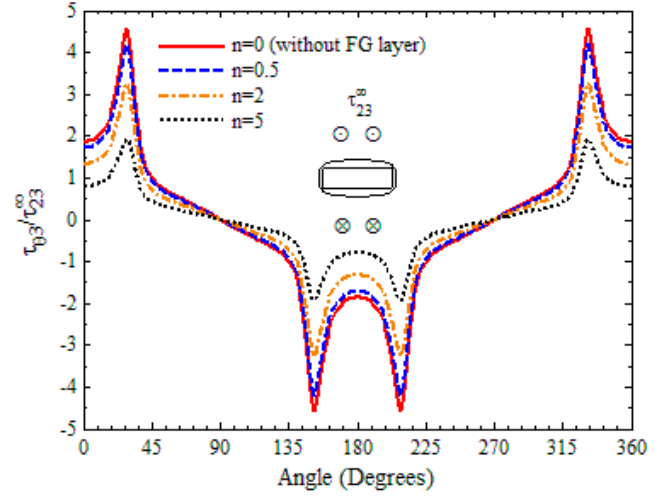
τ around the hole (rectangle). Figure 7. The variation in shear stress τ θ 3 around the hole 3 θ